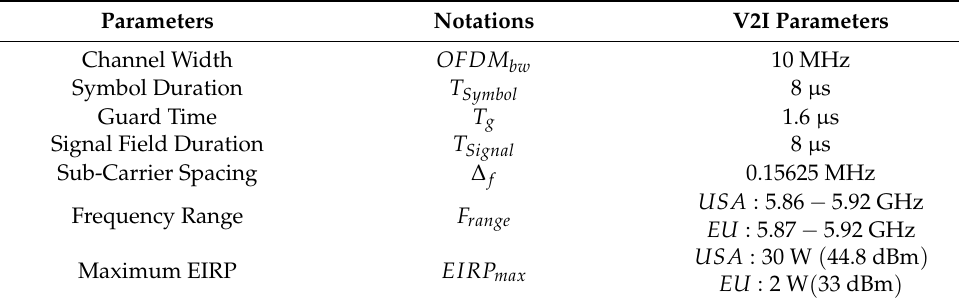
Table 3. Communication parameters of 802.11p PHY layer used for simulations